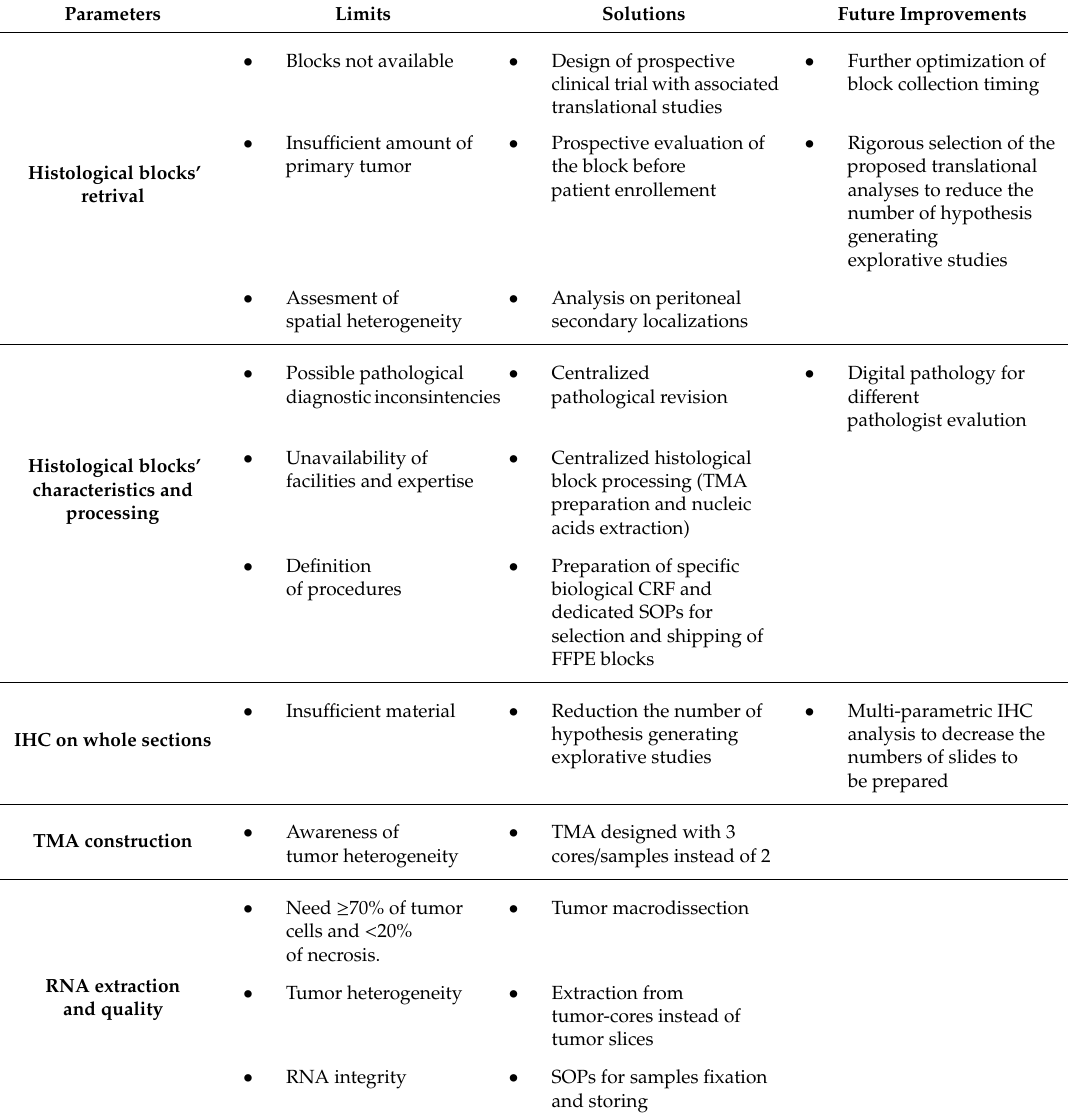
Table 4. MITO translational activity: lessons learned and proposed future improvements.